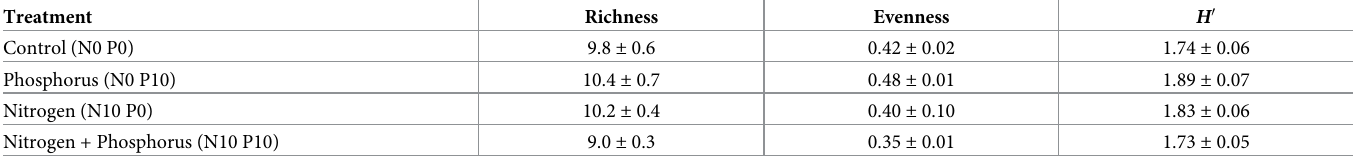
Table 3. Effects of nutrient additions on plant community metrics (richness, evenness, and Shannon’s diversity index [ H 0 ]).